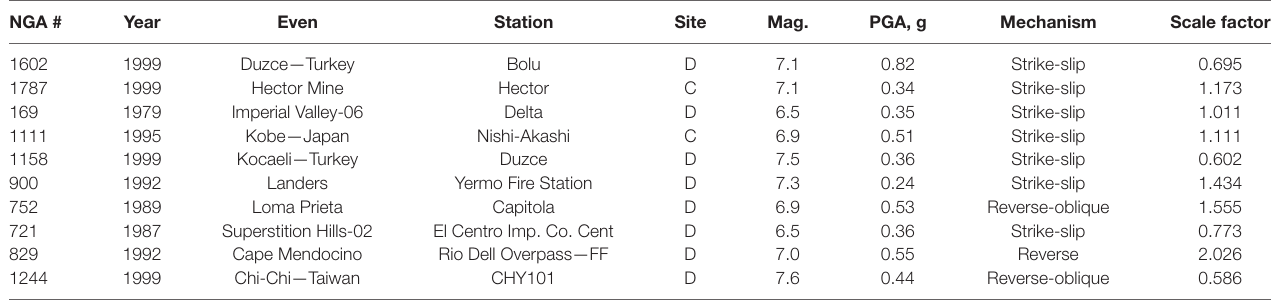
TaBle 3 | Summary of selected horizontal PEER ground motion records.